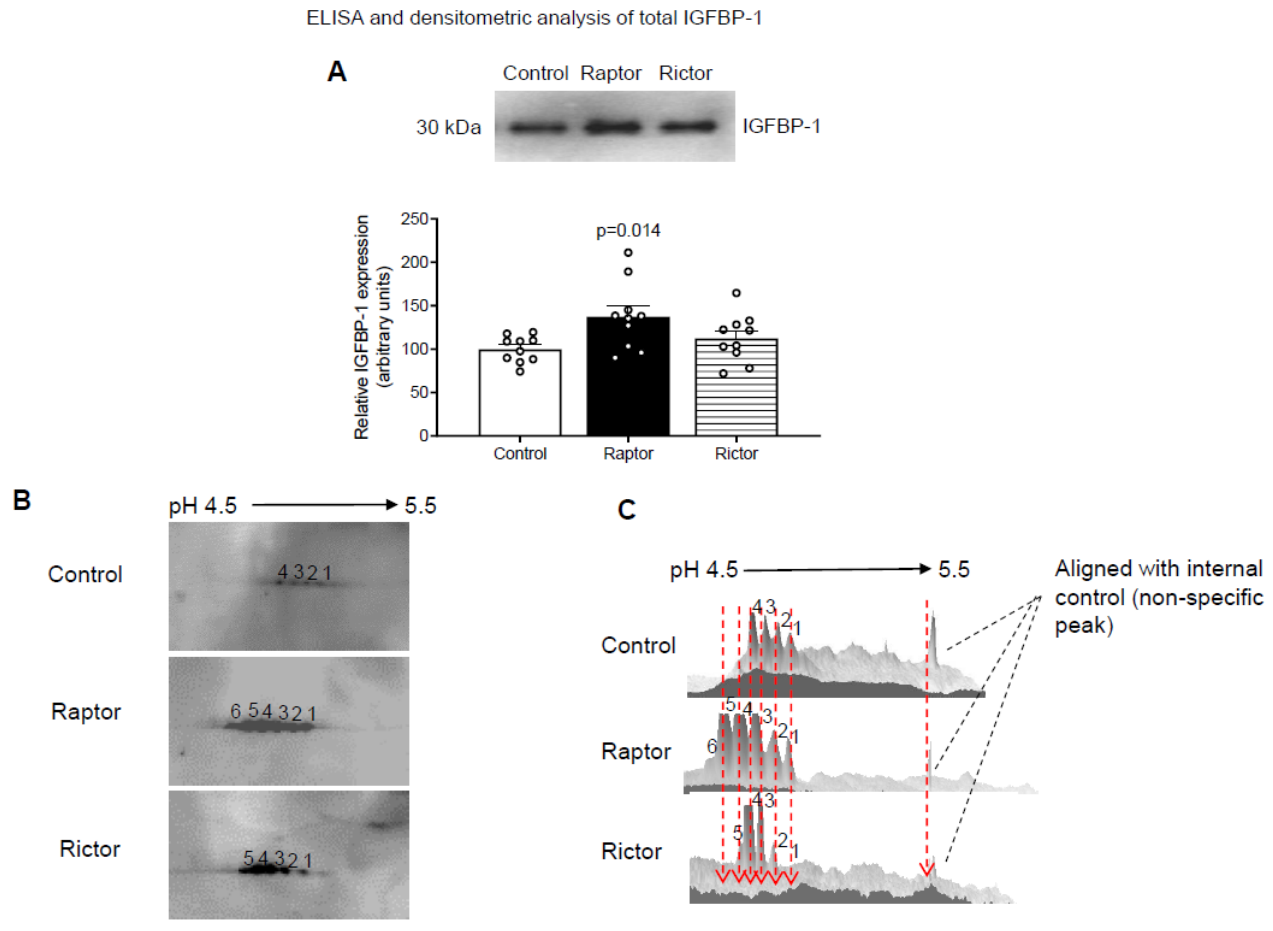
Figure 2. Analysis of IGFBP-1 secretion and IGFBP-1 phosphorylation by 1-D and 2-D immunoblot analysis using CM from HepG2 cells incubated with CM from PHT cells with the control, RAPTOR , and RICTOR siRNA. For a densitometric analysis ( A ), proteins in equal aliquots of CM from HepG2 cells (7 µ L) treated with CM from PHT cells with the control (non-coding siRNA), RAPTOR, and RICTOR siRNA were separated and probed using anti-human IGFBP-1 monoclonal antibody (mAb 6303). The data were normalized to the control (average arbitrarily set to 100) with Mean + SEM, analyzed with one-way ANOVA, and corrected with Bonferroni multiple comparison test; p < 0.05 was considered significant. ( B ) Equal aliquots of HepG2 CM (100 µ L) from PHT cells with Control (non-coding siRNA), RAPTOR, and RICTOR siRNA were exchanged against a rehydration buffer and loaded onto a 7 cm IPG strip followed by 2-D gel electrophoresis and a Western blot using anti-human IGFBP-1 polyclonal antibody. The spots on the blots ( B ) corresponded to IGFBP-1 phosphoisoform in CM from HepG2 cells treated with CM from PHT cells with the control (non-coding siRNA), RAPTOR , and RICTOR siRNA. The corresponding 3-D view ( C ) of IGFBP-1 phosphoisoform in the control, RAPTOR , and RICTOR is represented in the adjacent figure on the